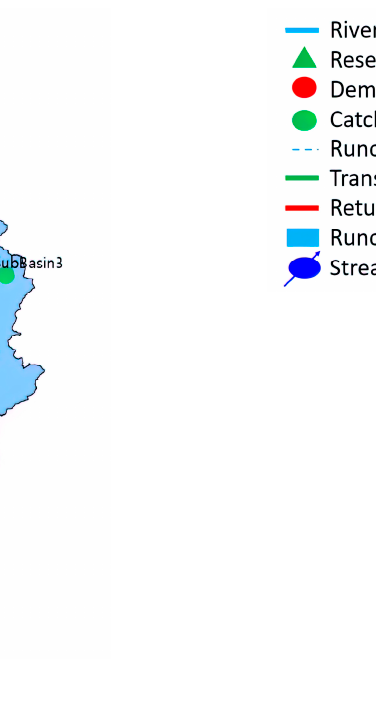
Figure 5. ( a ) Schematic of the VUB region in the WEAP model. ( b ) Legend.